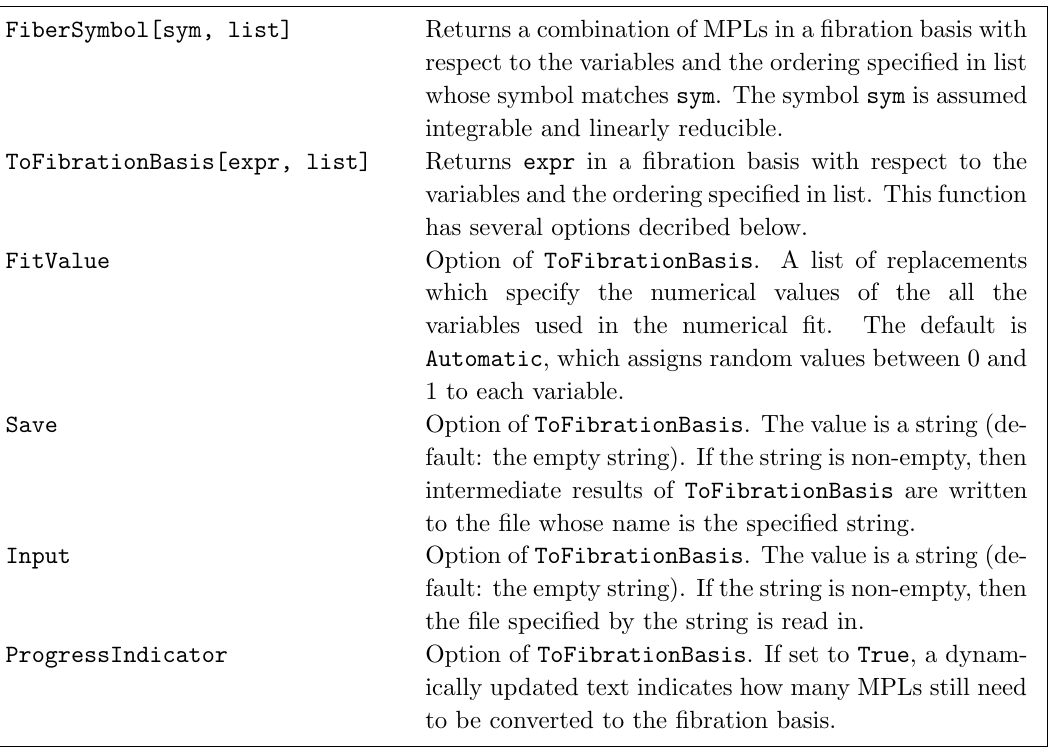
Table 7 . Manipulating expressions